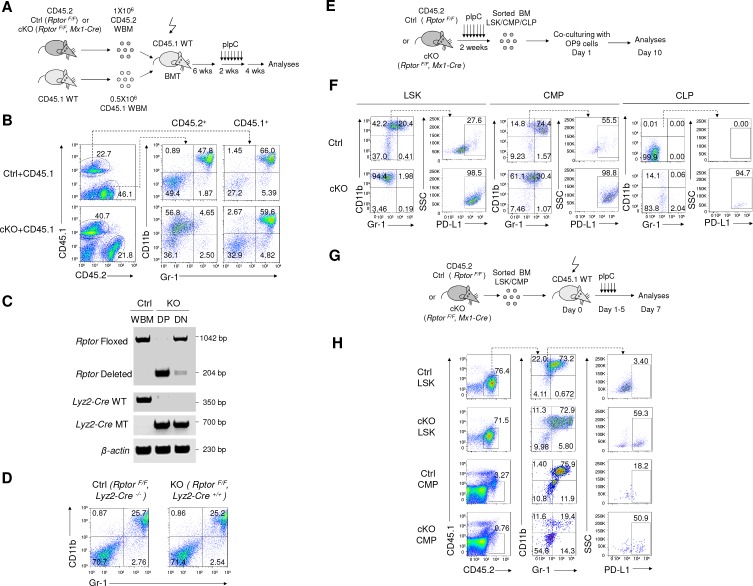
Raptor represses differentiation of IMLEC from CMP.(A, B) IMLEC accumulation in Rptor-/- BM is cell autonomous. (A) Diagram depicting generation of mixed BM chimera, induction of Rptor deletion and analyses for IMLEC. (B) In mixed BM chimera mice, IMLEC was accumulated only in the Raptor-deficient hematopoietic cells. Mice were sacrificed and analyzed at 4 weeks post pIpC treatment. CD45.1+ and CD45.2+ donor-derived BM cells were gated to show the myeloid subsets based on CD11b and Gr-1. Similar data were obtained in three independent experiments, each involving at least three mice per group. (C, D) BM IMLECs are not converted from CD11b+ Gr-1- granulocytes. (C) Genotyping and deletion efficacy. CD11b+Gr-1+ cells (DP) and CD11b-Gr-1- cells (DN) were sorted from BM of KO (RptorF/F, Lyz2-Cre+/+) mice. Floxed and deleted Rptor alleles, as well as Lyz2-Cre wild type (WT) and mutated (MT) alleles were confirmed by PCR. (D) Efficient deletion of Rptor in the CD11b+Gr-1+ compartment failed to cause IMLEC accumulation. Data shown are representative BM flow profiles of Ctrl mice and those with Rptor deletion in the CD11b+Gr-1+ compartment, depicting distributions of CD11b and Gr-1 markers in adult mice. Similar data have been obtained in three experiments, involving a total of 5 mice per group. (E, F) Rptor-/- LSK, CLP and CMP cells differentiate into IMLECs in vitro. (E) Diagram of experimental design. 2 × 103 LSK cells or 5 × 104 CLP or 5 × 104 CMP cells were co-cultured with the OP9 cells for 10 days. (F) Rptor deletion promoted generation of IMLEC. The CD45.2+ leukocytes were gated and analyzed for their expression of CD11b, Gr-1 and PD-L1. Data shown are representative of three independent experiments. (G, H) Both LSK and CMP cells differentiate into IMLECs in vivo. (G) Diagram of BM cells transplantation. FACS-sorted, Ctrl or cKO LSK cells (5 × 104/mouse) or CMP cells (1.2 × 105/mouse) were injected i.v. to CD45.1 recipient mice which were immediately administrated with five daily pIpC treatments. BM cells were harvested on day seven for FACS analyses. (H) Rptor deletion promoted differentiation of progenitor cells into IMLEC. Donor-derived CD45.2+ BM cells were gated to analyze surface markers CD11b, Gr-1 and PD-L1. Data shown are representative flow profiles from one of 3 independent experiments.